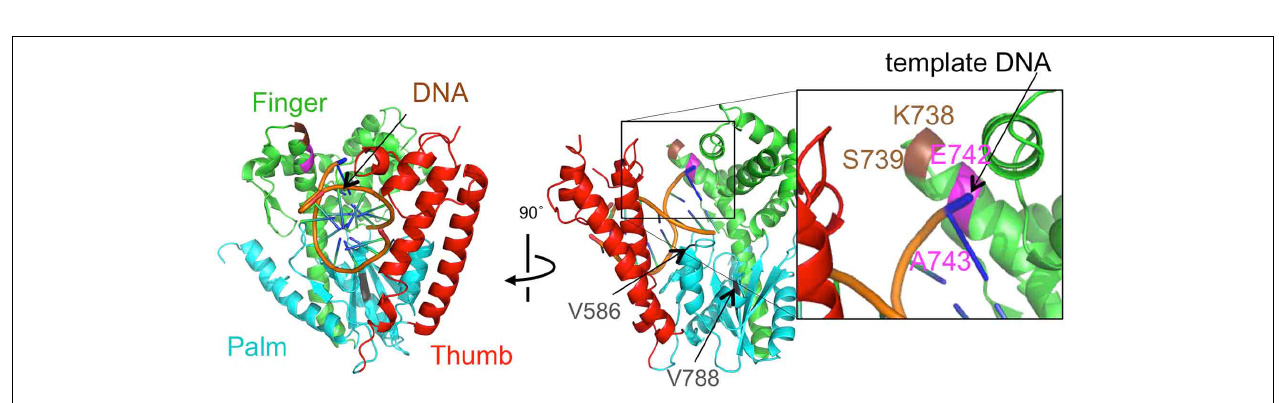
FIGURE 4 | The mutational sites of Taq DNA polymerase. The crystal structure of Taq polymerase with DNA is shown (PDB, 1TAU). The 5 (cid:2) to 3 (cid:2) exonuclease domain is not illustrated for clarity. The polymerase domain is composed of a right hand with finger (green), palm (cyan), and thumb (red) subdomains (Eom et al., 1996). The thumb and finger subdomains hold DNA